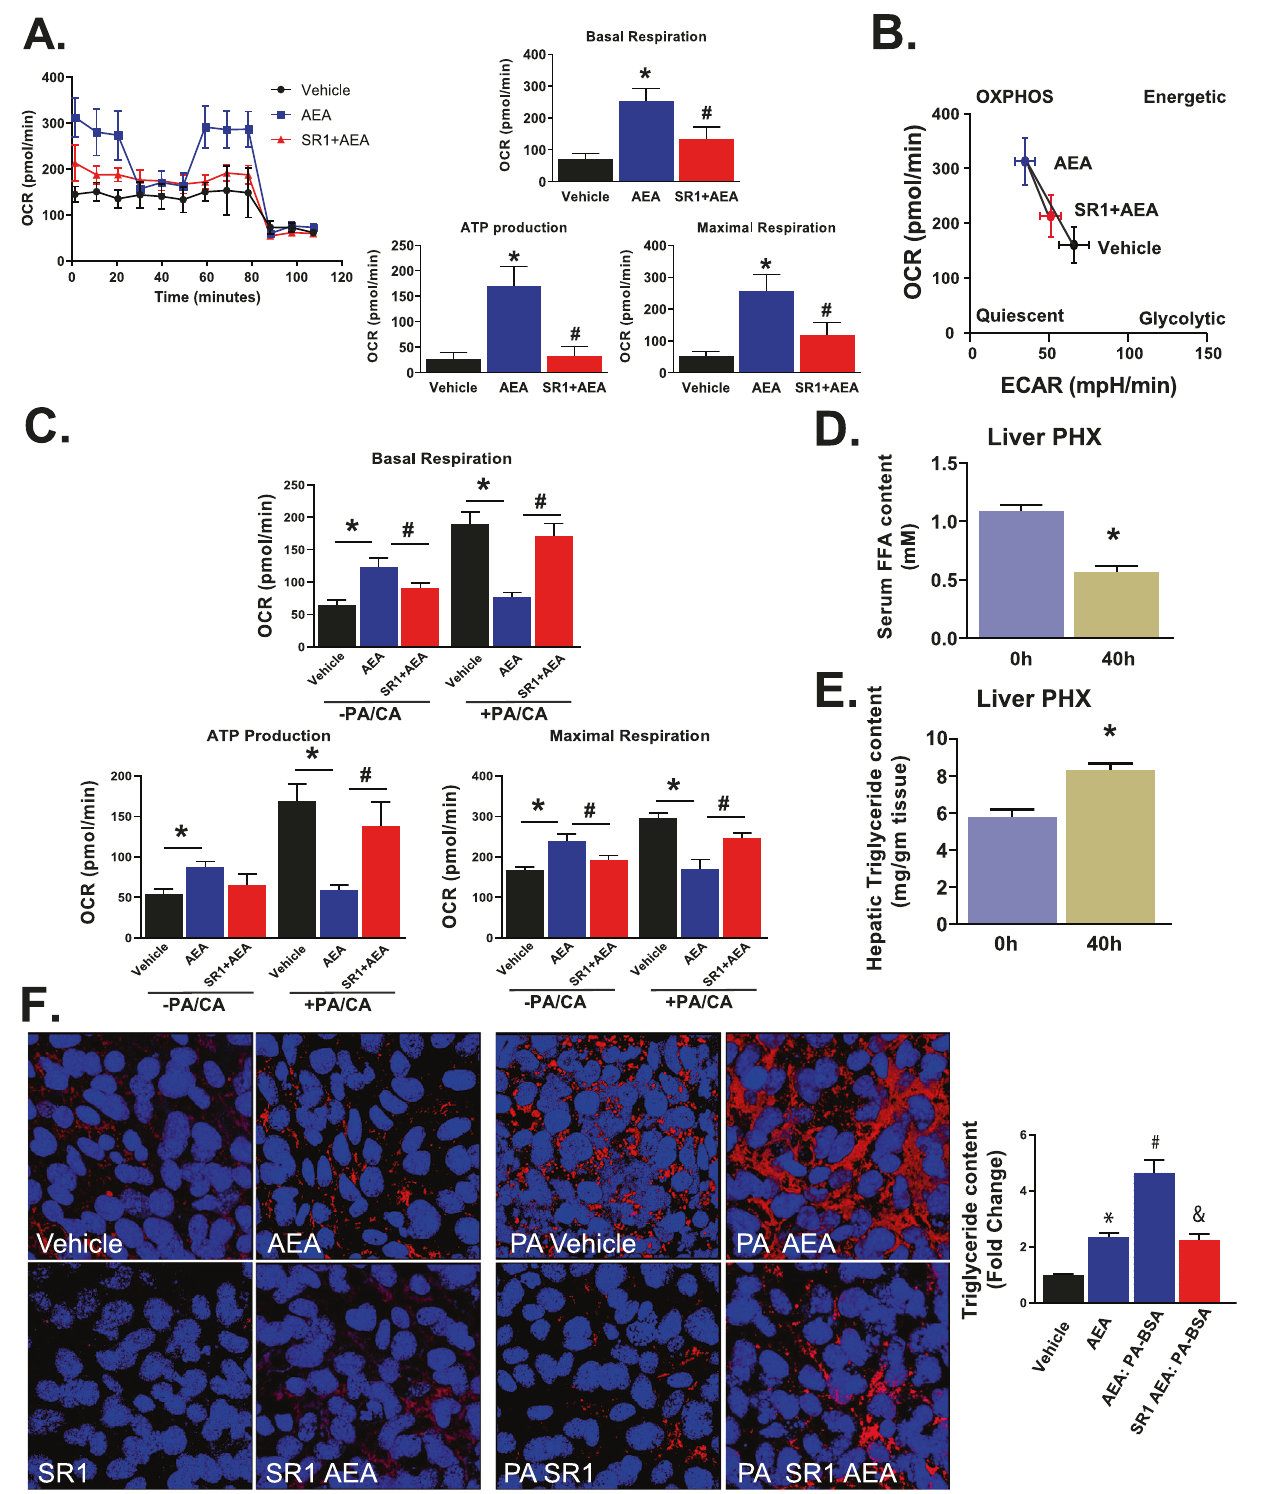
Fig. 6 AEA regulates mitochondrial metabolism and energy homeostasis in mouse HPCs. A Oxygen consumption rate (OCR) under “ full substrate ” (see “ Methods ” ) measured in the presence of vehicle, AEA (0.3 μ M) or AEA + SR1 (1 μ M). Basal and maximal respiration and ATP production were quanti fi ed. Columns and vertical bars denote means and SE, * and # indicate signi fi cant difference from the vehicle or AEA group, respectively, ( P < 0.05, n = 6/group). B Energy map plot of OCR versus extracellular acidi fi cation rate (ECAR). C OCR under “ limited substrate ” in the absence (left 3 columns) or presence of 175 μ M palmitate (right 3 columns). Parameters measured as in ( A ). Statistics and symbols as in ( A ). D Serum free fatty acid (FFA) content at 0 h and 40 h post-PHX); E Liver TG in content at 40 h post-PHX and in the remnant liver (0 h). F Effect of AEA on lipid droplet accumulation in the absence or presence of added palmitate and rimonabant (SR1) (left) and the quantitation on TG content (right). Columns and vertical bars denote means and SE, * indicates P < 0.05; n = 6/group.